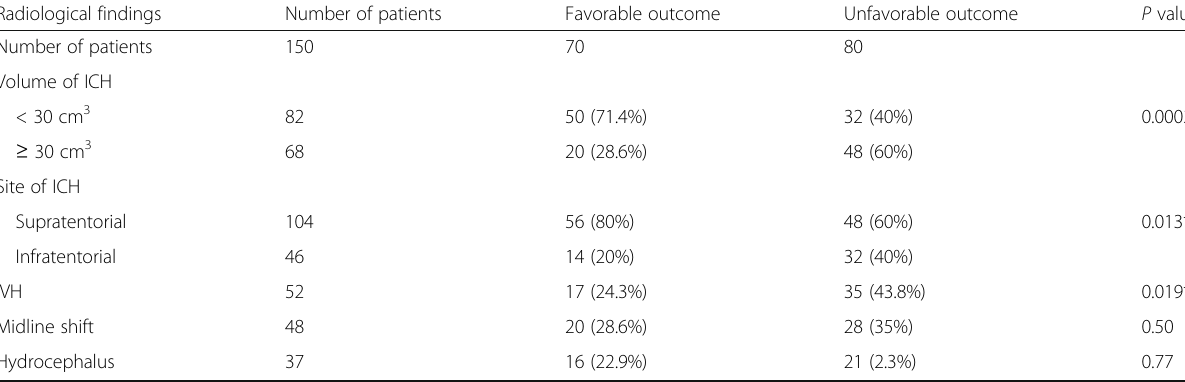
Table 2 Radiological findings and prognosis in cases of